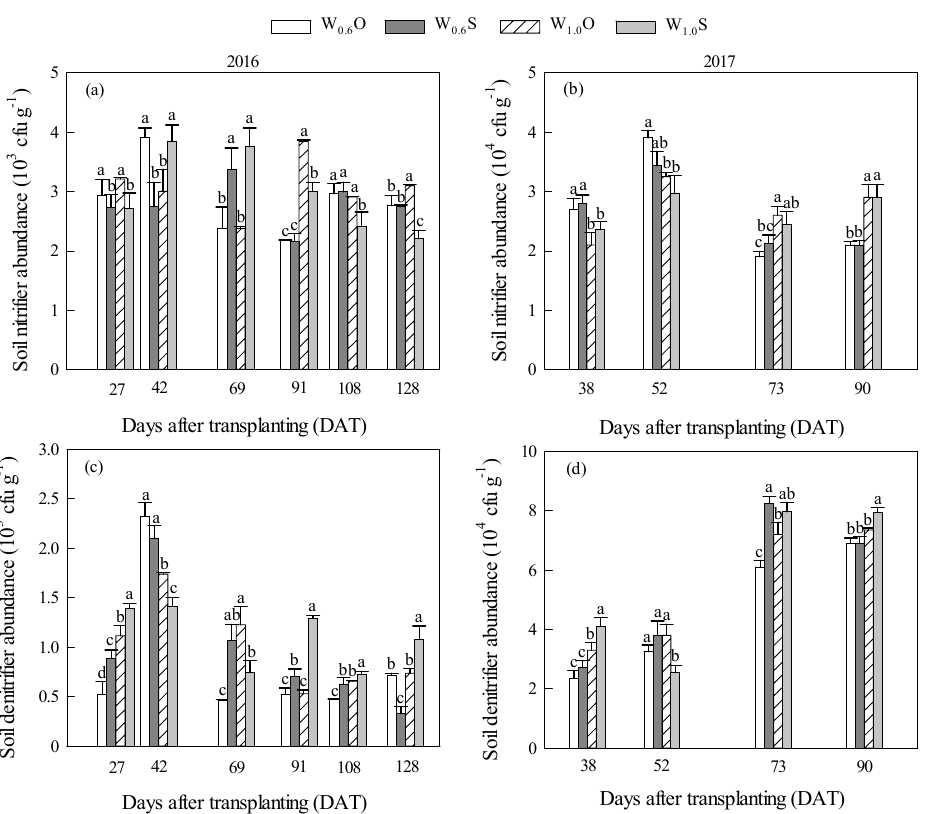
Figure 5. Variations of soil nitrifier ( a , b ) and denitrifier ( c , d ) abundance among treatments. ( a , c ) and ( b , d ) represent soil microbes in the greenhouse tomato-growing seasons of 2016 and 2017, respectively.